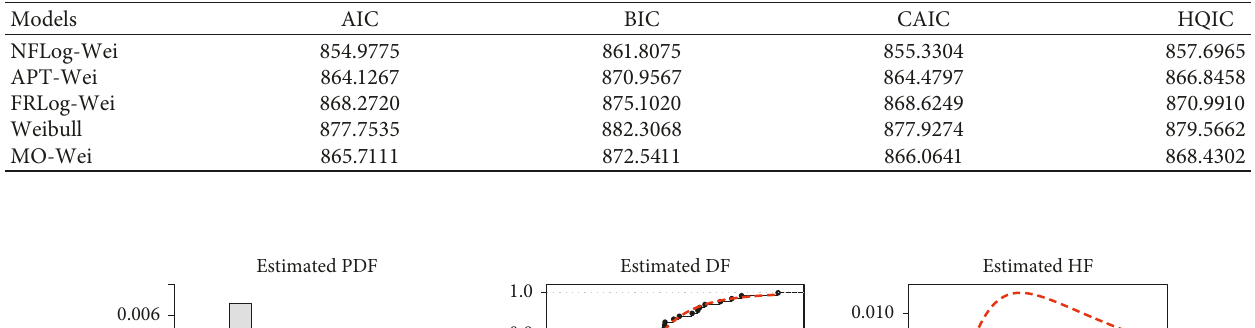
Table 9: The values of AIC, BIC, CAIC, and HQIC of the fitted probability models for Data 2.